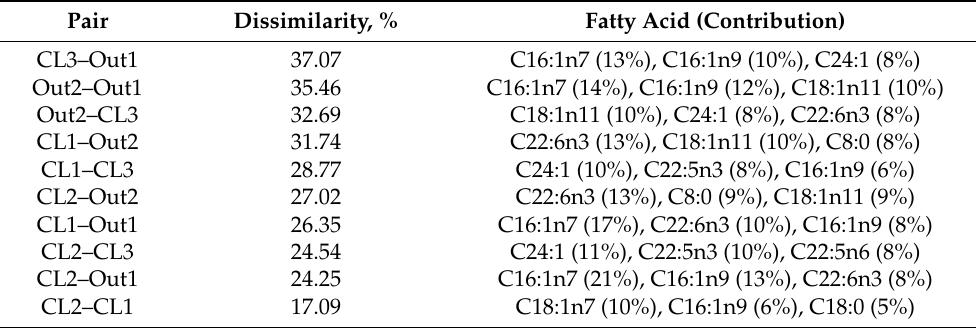
Table 3. SIMPER (similarity percentages routine) results; fatty acids mostly contributing to the dissimilarity between clusters delineated based on square-root transformed concentrations of fatty acids in pike from different